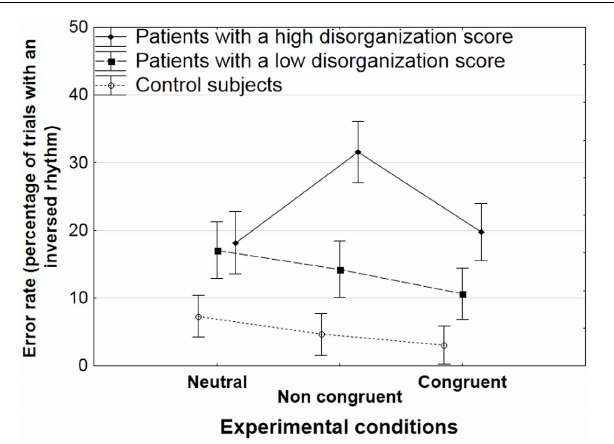
FIGURE 4 | Mean tap-tone asynchrony (with standard error of the means, SEM) on the 2d tap, for correct trials averaged across participants in each group (patients with a low and high level of disorganization, and controls) as a function of the experimental condition (neutral, non-congruent,